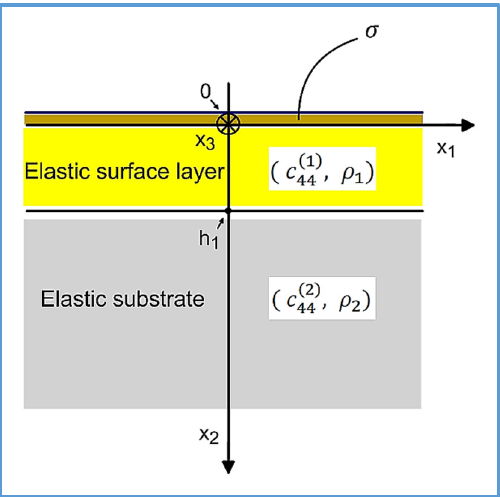
Figure 2. Cross-section of the Love wave waveguide loaded with an infinitesimally thin layer of lossless mass with a surface density σ kg/m 2 . Love surface waves propagate in the direction of axis x 1 . Shear horizontal (SH) mechanical displacement u 3 of the Love wave is polarized along the x 3 axis.